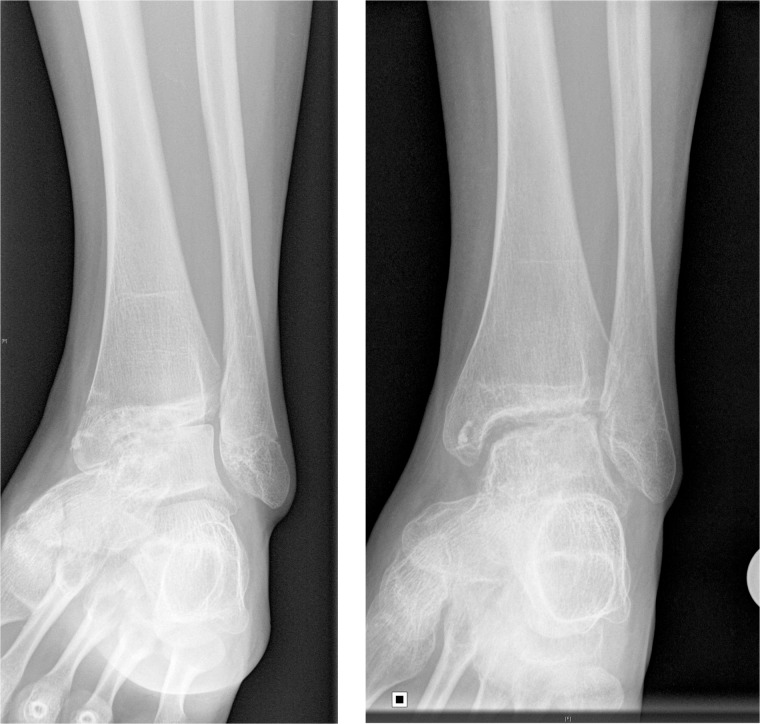
Plain radiographs illustrating increased joint space (pre-operative on left and post-operative on right).